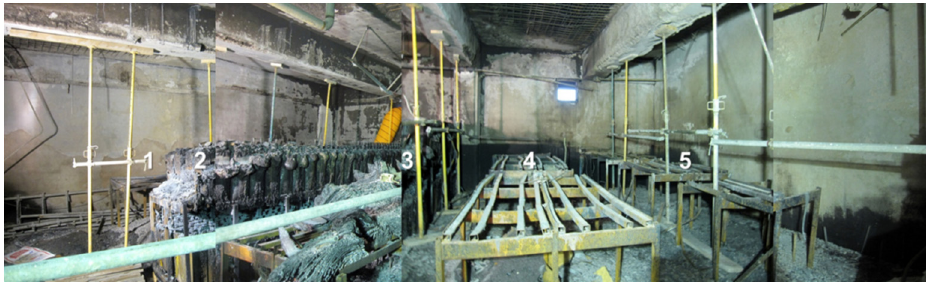
Figure 2. Panoramic view of the battery room during visual inspection.